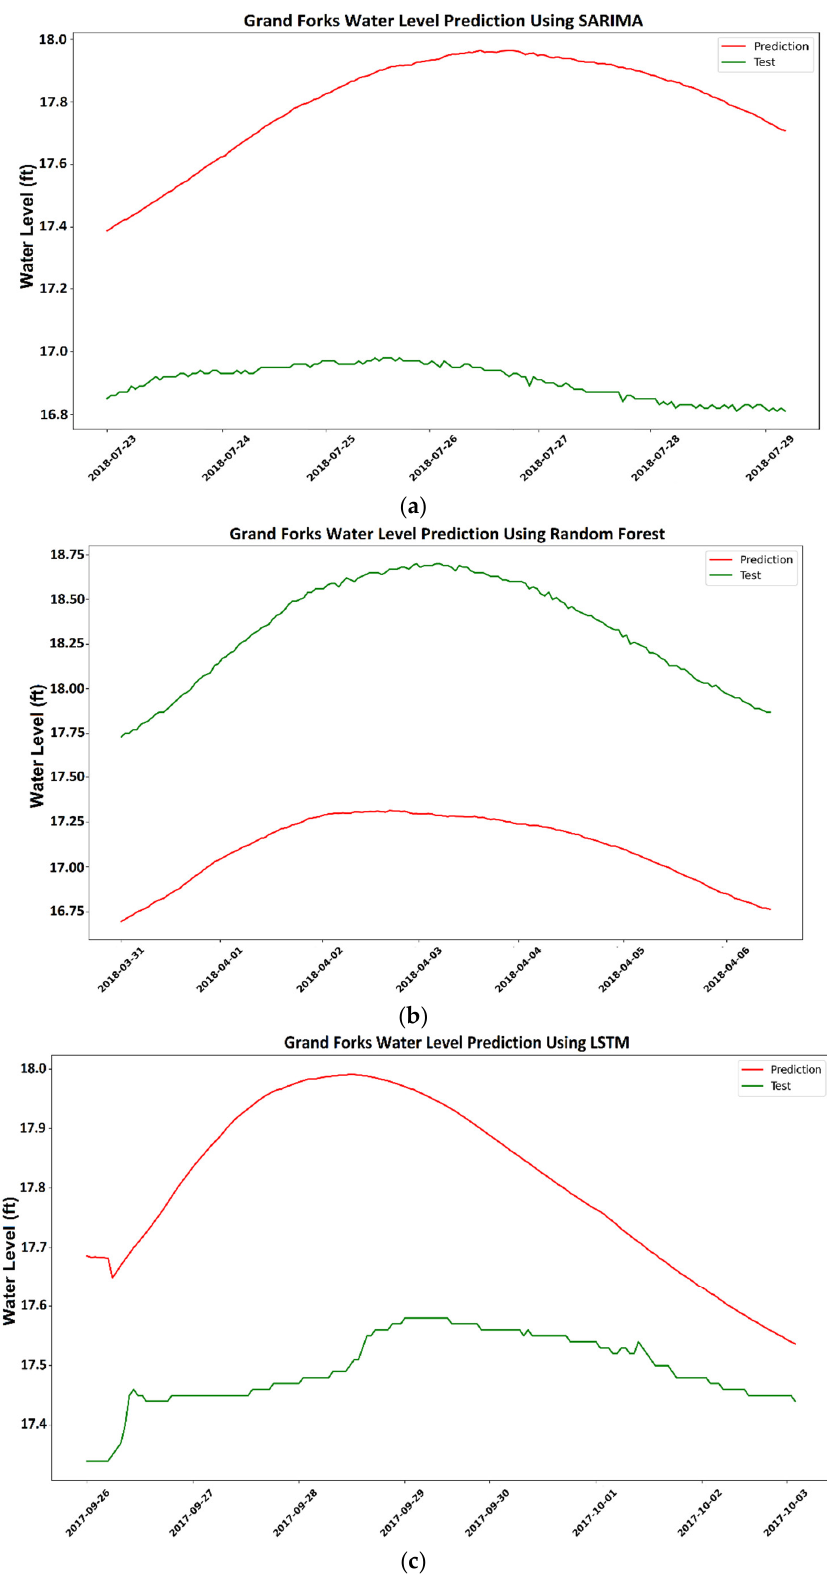
Figure 7. Visual comparison of one-week-ahead predicted values using ( a ) SARIMA, ( b ) RF, and ( c ) LSTM forecasting methods with true values on Grand Forks series.